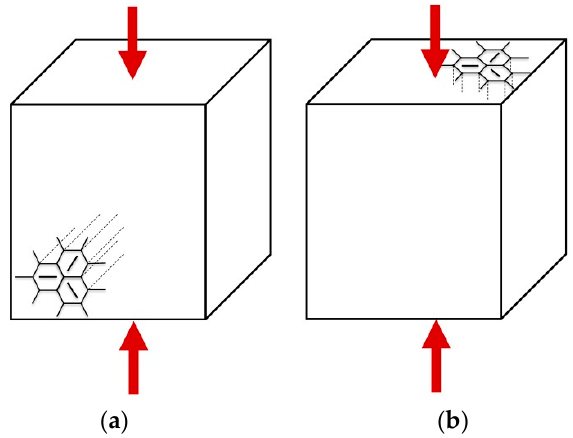
Figure 2. Two loading directions: ( a ) Horizontal loading, i.e., loading perpendicular to the length of the columns; and ( b ) Vertical loading, i.e., loading along the length of the columns.